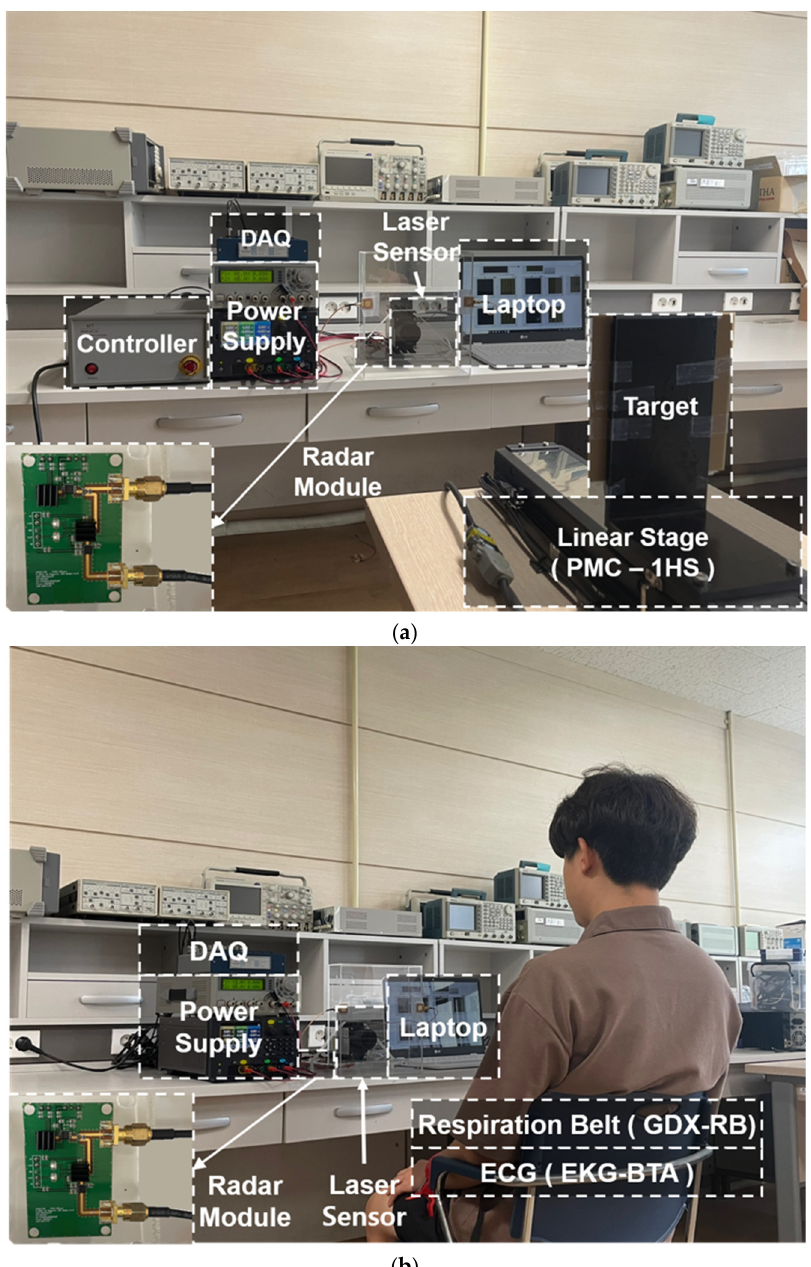
Figure 9. Experiment setup using the radar sensor: ( a ) displacement measurement; ( b ) vital signal detection.